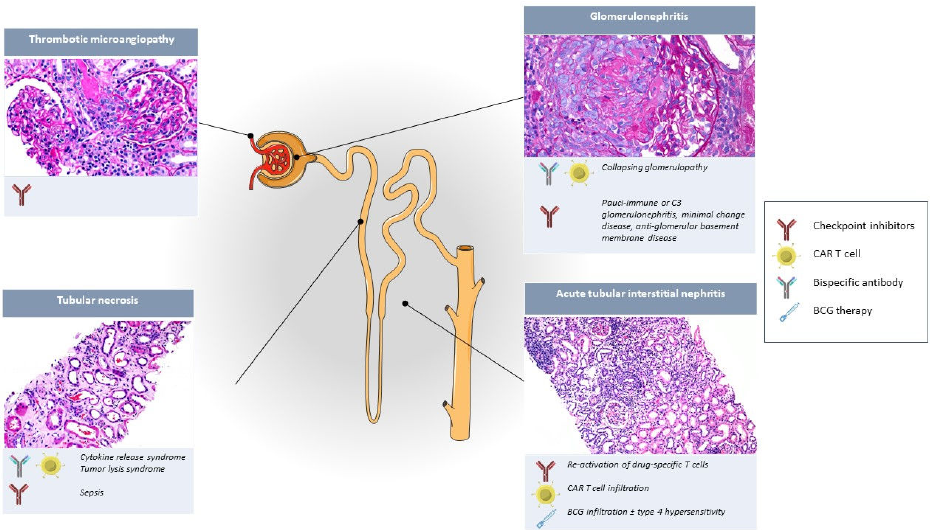
Figure 1. Acute kidney injury causes in cancer immunotherapy recipients and their site of injury